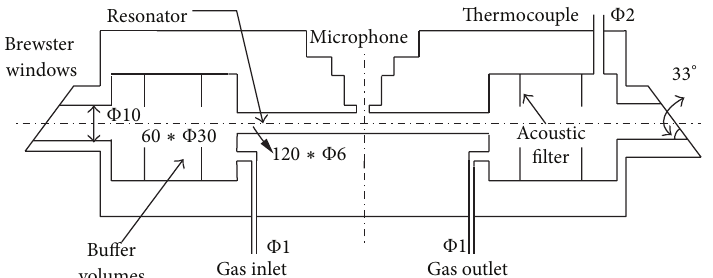
Figure 4: The longitudinal section drawing of the PA cell.